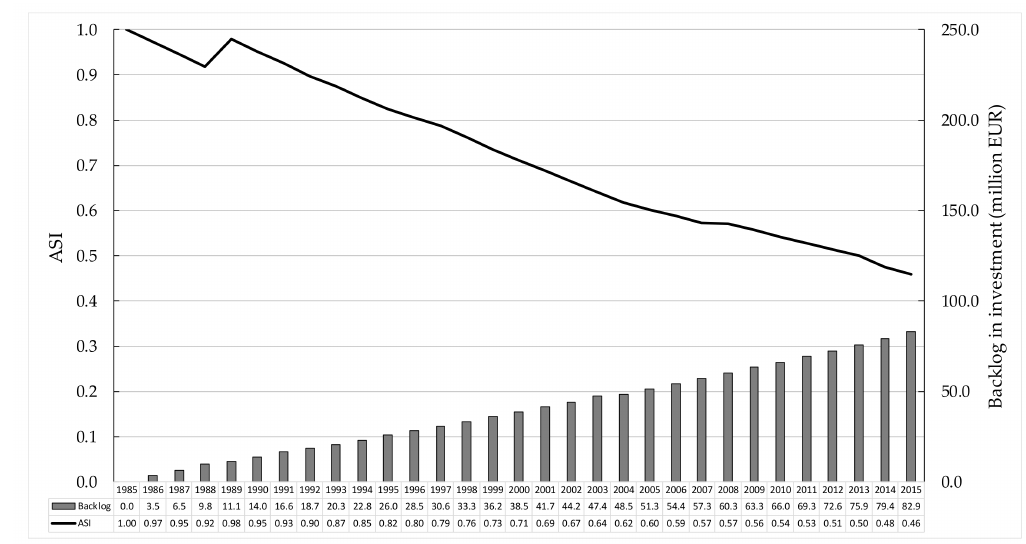
Figure 8. Operational Sub-system 1. ASI and investment backlog.